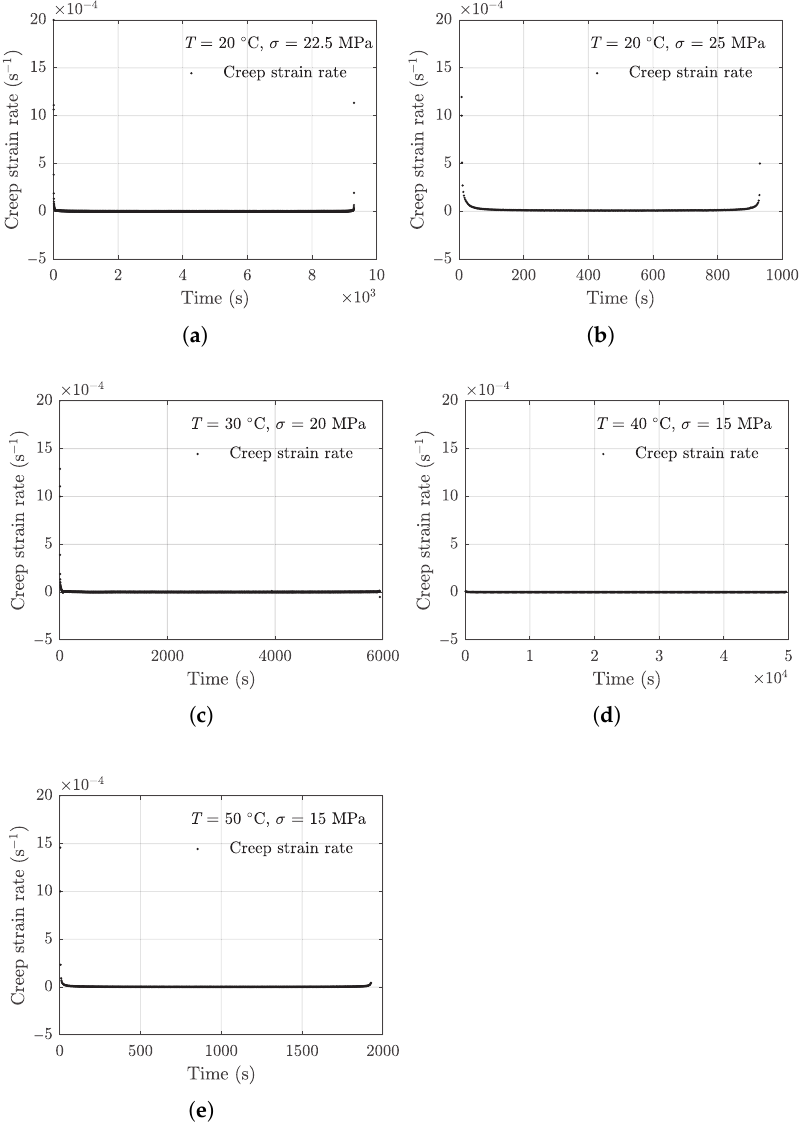
Figure 6. Creep strain rate data. ( a ) 20 ◦ C, 22.5 MPa, ( b ) 20 ◦ C, 25 MPa, ( c ) 30 ◦ C, 20 MPa, ( d ) 40 ◦ C, 15 MPa, ( e ) 50 ◦ C, 15